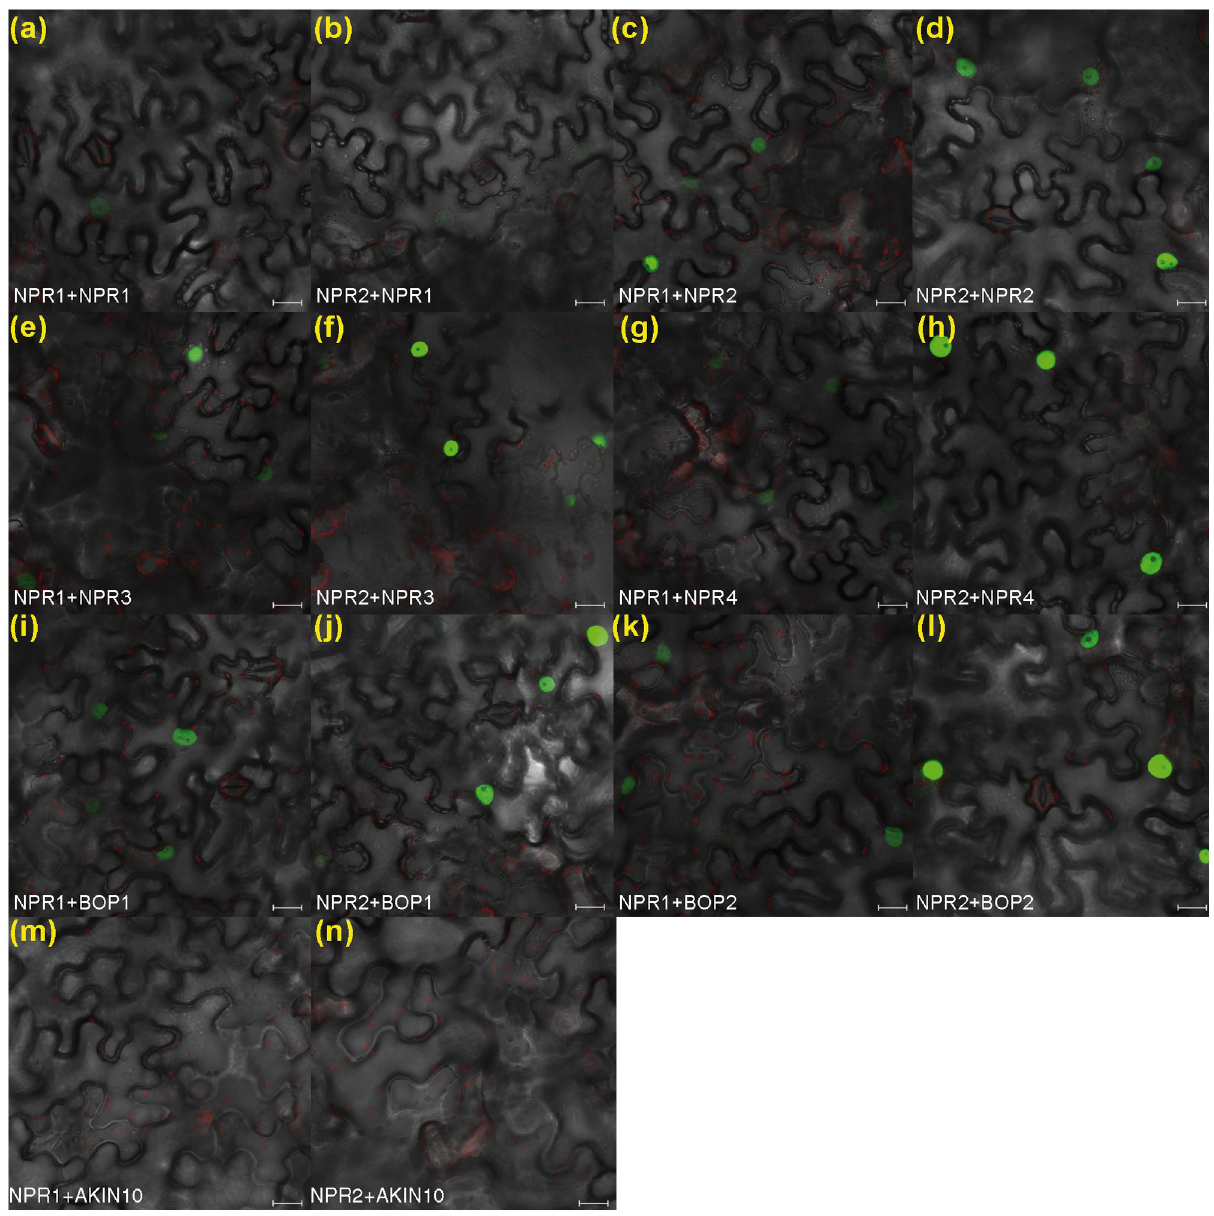
Fig 6. In planta interactions among NPR1 paralogs. Bimolecular fluorescence complementation (BiFC) among NPR1 paralogs. The constructs were agroinfiltrated with 1mM SA treatment one day before visualization. The first protein is fused with the N-terminal part of GFP, and the second with the C-terminal. (a) NPR1 and NPR1. (b) NPR2 and NPR1. (c) NPR1 and NPR2. (d) NPR2 and NPR2. (e) NPR1 and NPR3. (f) NPR2 and NPR3. (g) NPR1 and NPR4. (h) NPR2 and NPR4. (i) NPR1 and BOP1. (j) NPR2 and BOP1. (k) NPR1 and BOP2. (l) NPR2 and BOP2. (m) NPR1 and AKIN10, as a negative control[37]. (n) NPR2 and AKIN10, as a negative control. The bars in these pictures represent 20 μ m.